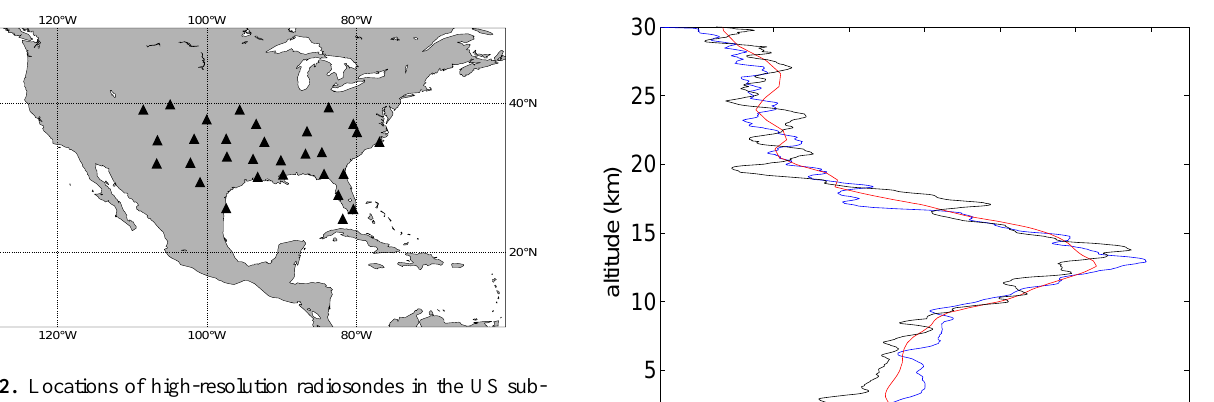
Fig. 12. Locations of high-resolution radiosondes in the US sub- tropical region between 20 ◦ N and 40 ◦ N and between 75 ◦ W and 110 ◦ W.